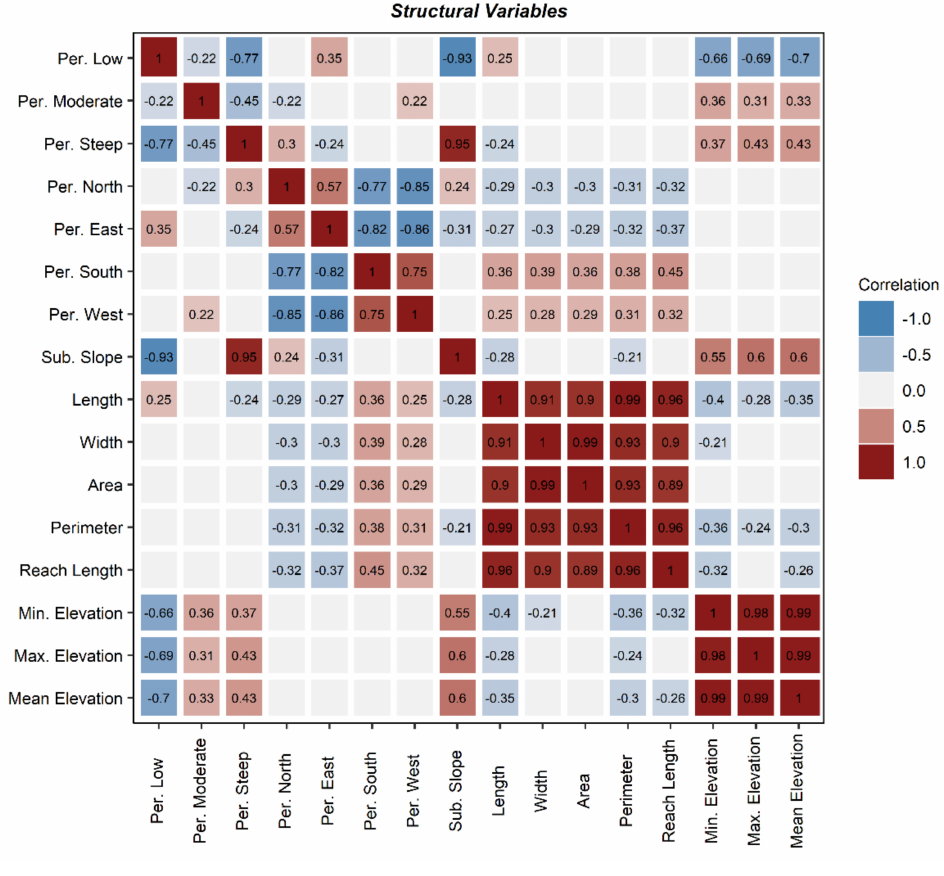
Figure 2. Correlations between the full list of structural variables from − 1 (blue) to 1 (red). Non- significant correlations ( p -value > 0.05) were